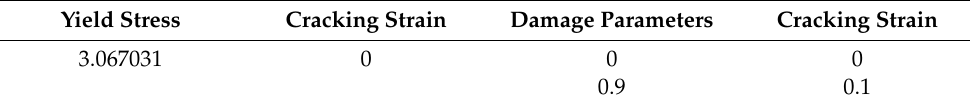
Table 8. Concrete tensile damage.